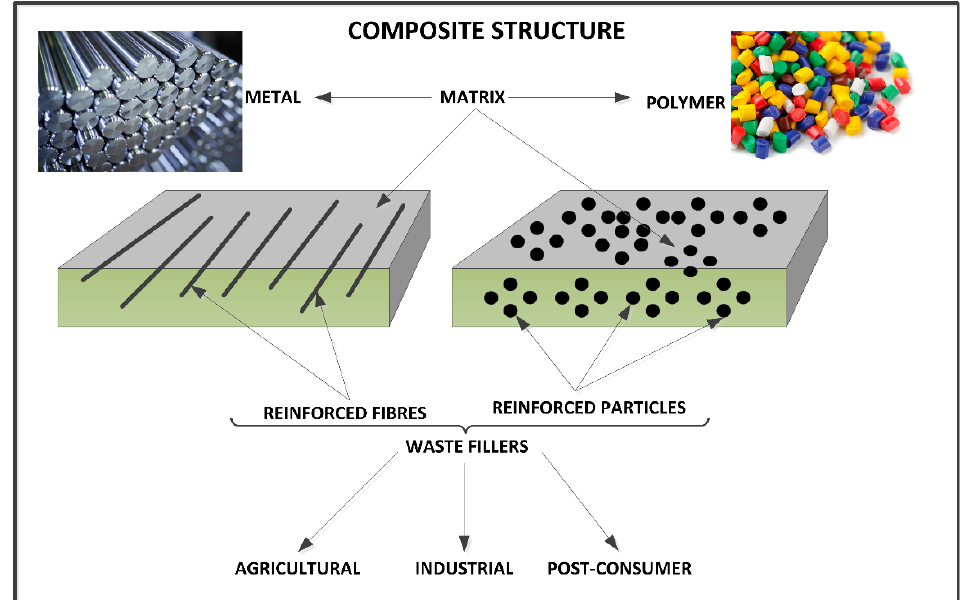
Figure 2. The general structure of metal- and polymer–matrix composites filled with various waste materials.